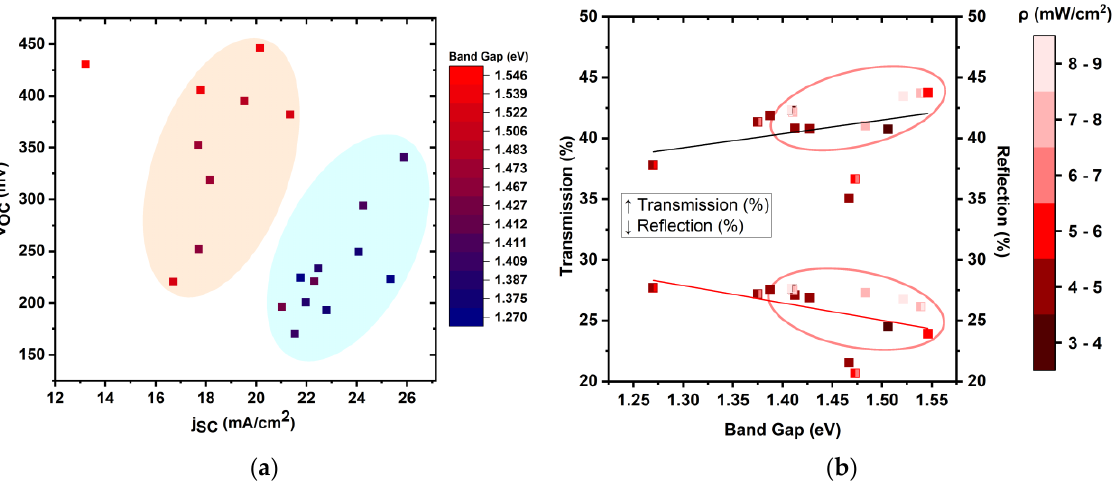
Figure 8. ( a ) Correlation of j sc and V oc with E g grouped in low (E g from 1.27 to 1.43 eV, bluish) and high (E g from 1.477 to 1.55 eV, reddish) values; ( b ) Power density of ACIGSe solar cells along with the evolution of transmission and reflection depending on the band gap.